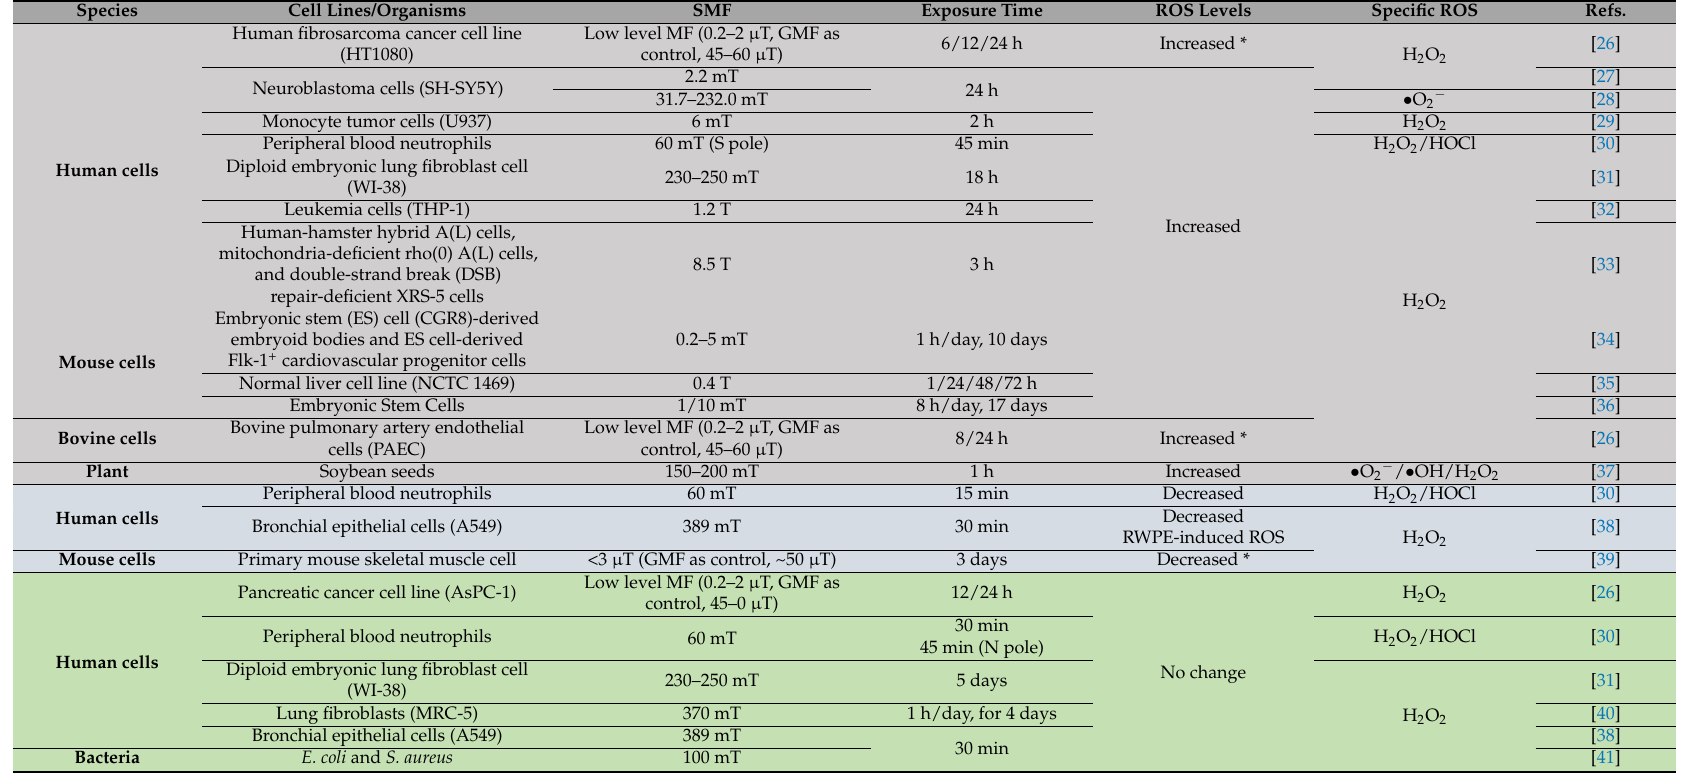
Table 1. Reactive oxygen species (ROS) changes induced by static MFs